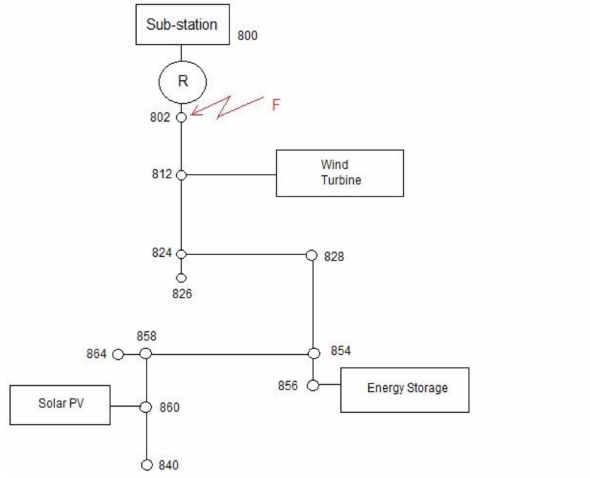
Figure 1. Application of a recloser in a radial distribution feeder with distributed generation inte- grated [26,27].